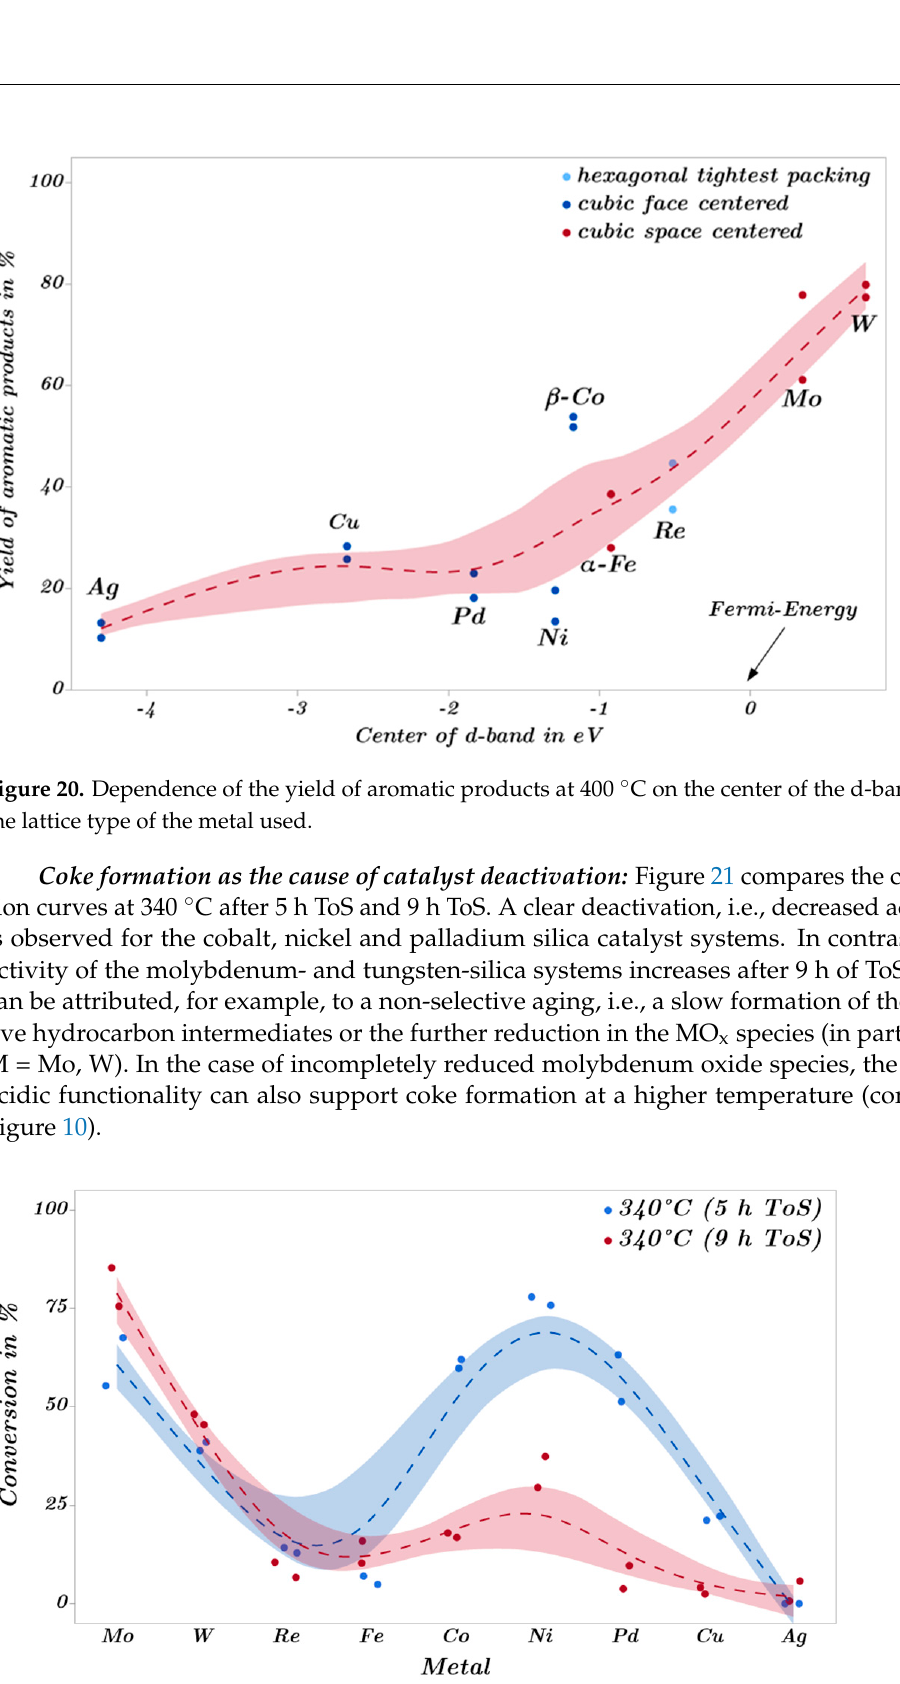
Figure 21. Comparison of the conversion curves in the test measurements of the metal-silica catalyst systems at 340 °C after 5 h ToS (blue) and 9 h ToS (red) as a check of the deactivation of the material. The dashed smoothing is based on a spline with λ = 0 and the confidence interval.